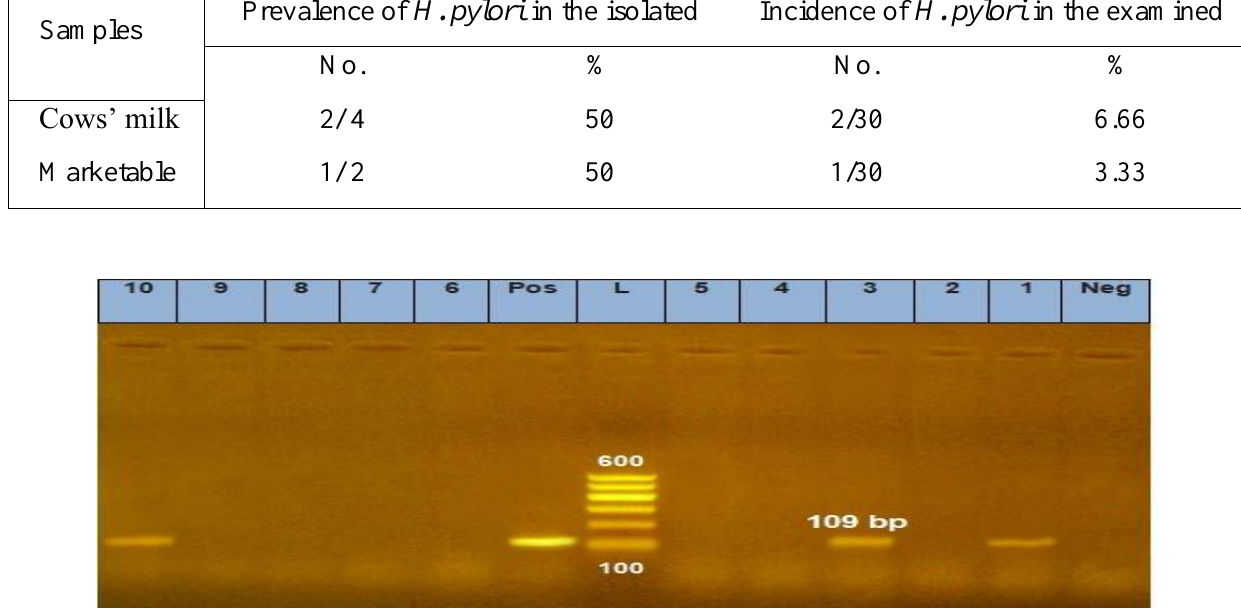
Table 3: Results of molecular conformation of the isolated H. pylori strains by using PCR technique: Samples